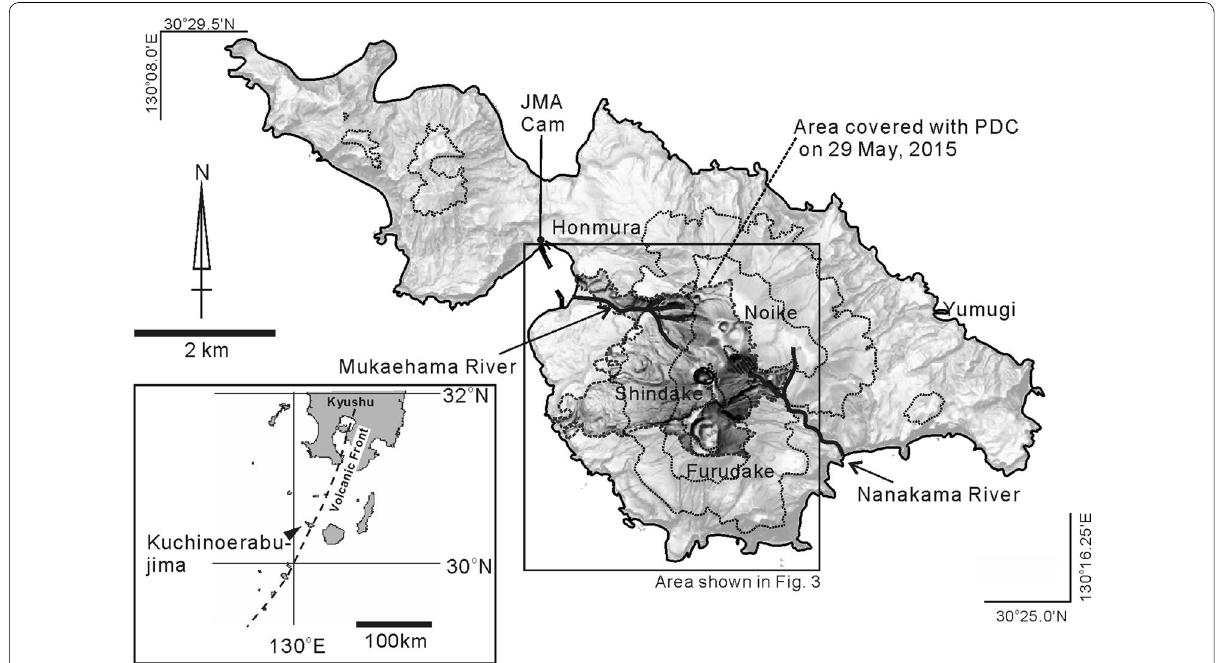
Fig. 1 Topographic map of the Kuchinoerabujima Island. The relief map was created using the 10-m-mesh digital elevation model provided by Geospatial Information Authority of Japan. The counters are at 200-m intervals. Mukaehama River and Nanakama River are shown with broad black lines. The shadowed area surrounded by dotted line represents the area covered by the pyroclastic density current (PDC). Locations of the monitoring camera operated by Japan Metrological Agency (JMA cam) are